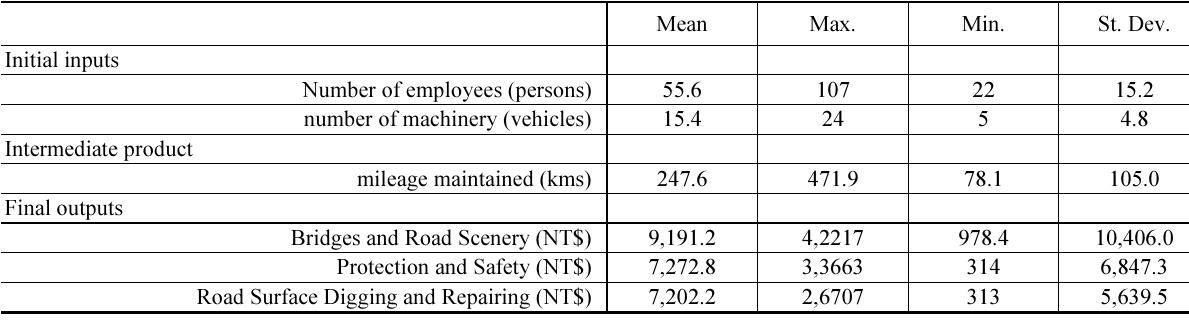
Table 4. Descriptive statistics of inputs and outputs